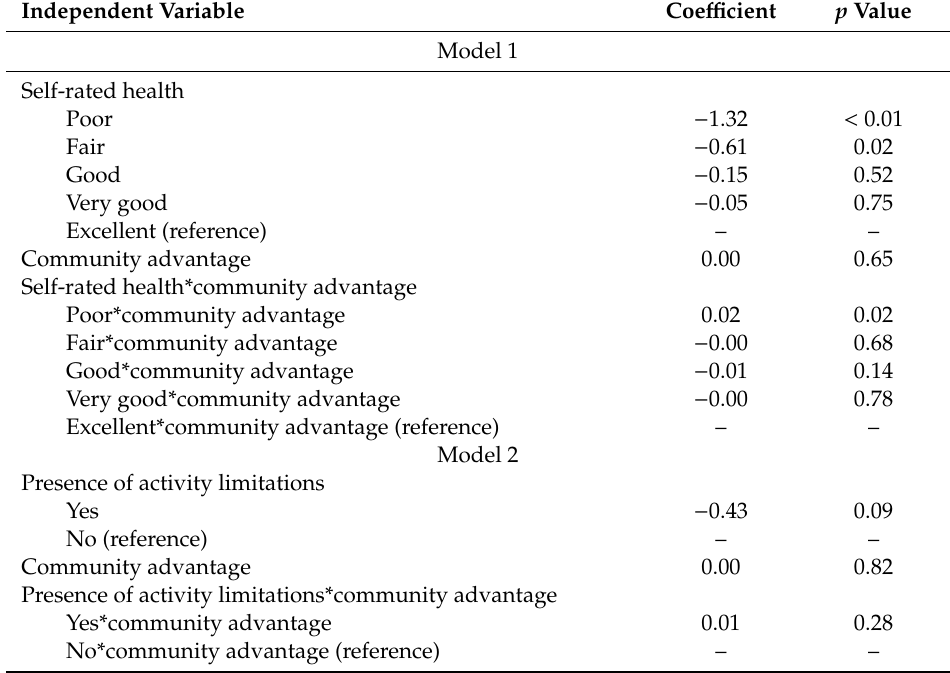
Table 3. Disaster preparedness vs. disability measures with community advantage moderation, Los Angeles County, 2013 ( n = 4700) a